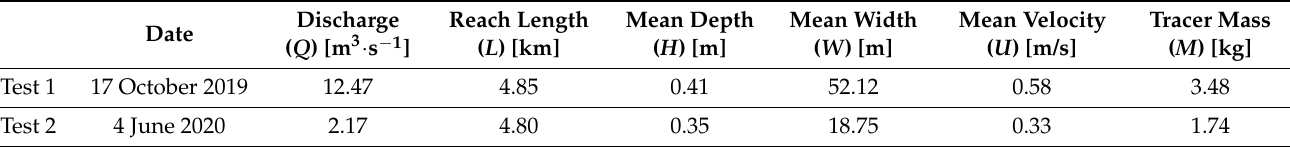
Figure 4. Photograph of the behavior of a tracer cloud that depicts the storage zone effect in the Gam Creek test reach. Table 3. Experimental condition of the field tracer tests in Gam Creek, South